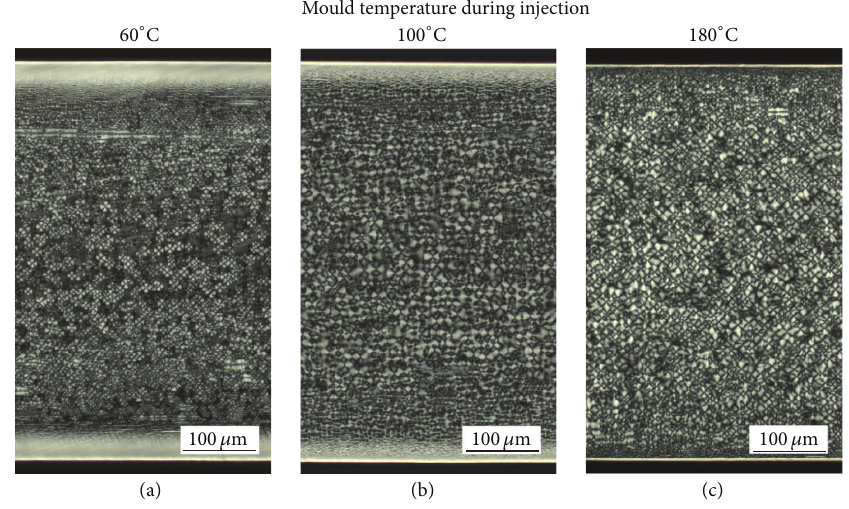
Figure 3: Morphology in dependence of process conditions.